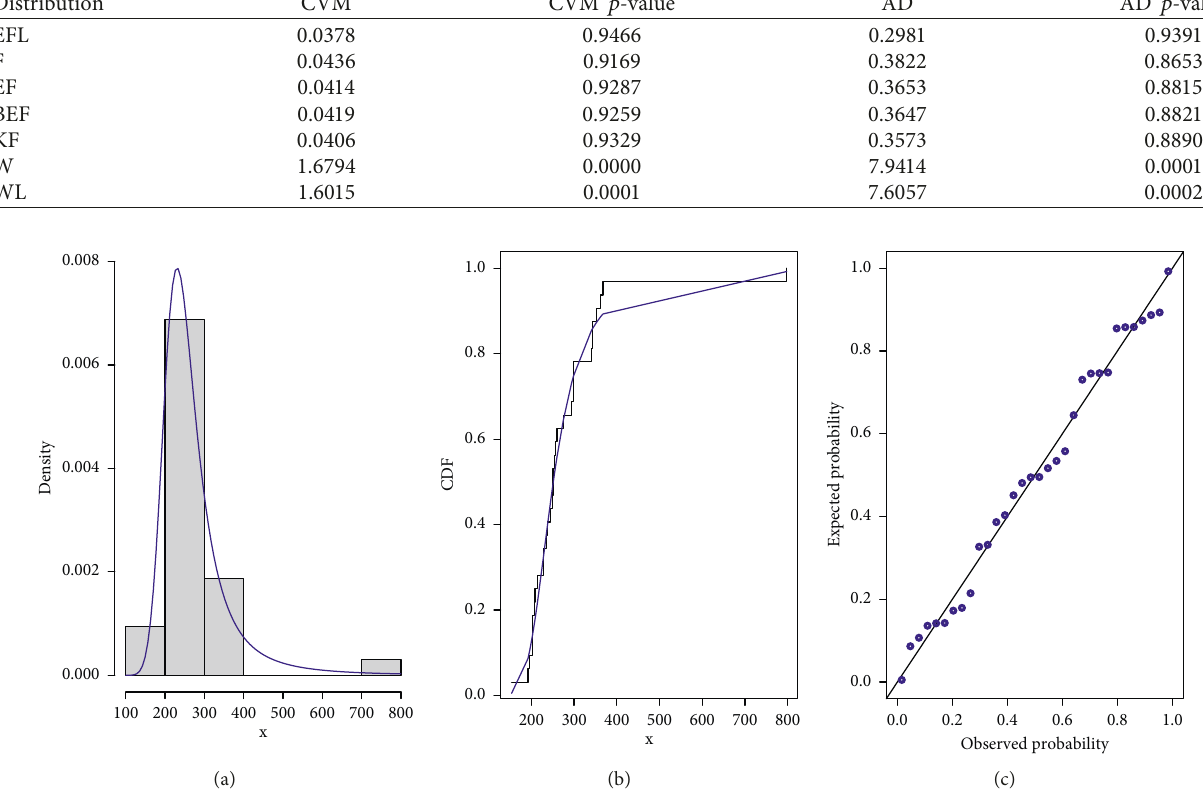
Figure 8: Histogram, CDF, and PP plots of EFL distribution for collision